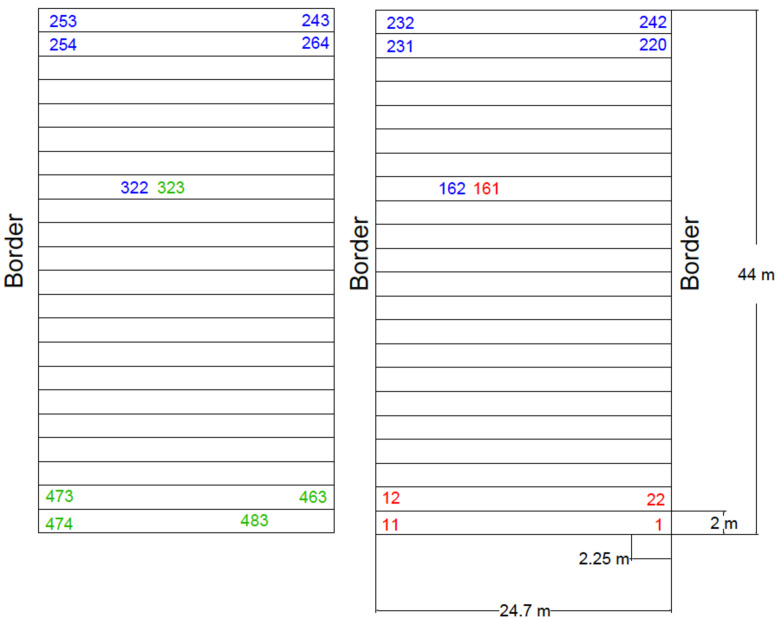
Plan of the Ameca field design.Summer experimental field 2019, located in Ameca, Jalisco. Three complete blocks were evaluated. Forty-five seeds were sown per three-row plot (15 seed per row). AMF-S and AMF-R families were alternated with the order of the families within each subpopulation randomized within each block. The rows marked with red, blue, and green correspond to blocks 1, 2, and 3, respectively. A commercial UNISEM hybrid was planted on the border of the experiment and used as a check throughout the field. The field was fertilized at planting with 250 kg / Ha of diammonium phosphate (DAP) as a source of nitrogen and phosphorus (18-46-00, NPK). A further application of 250 kg / Ha of urea was given (46-00-00, NPK) at 40 days after planting.